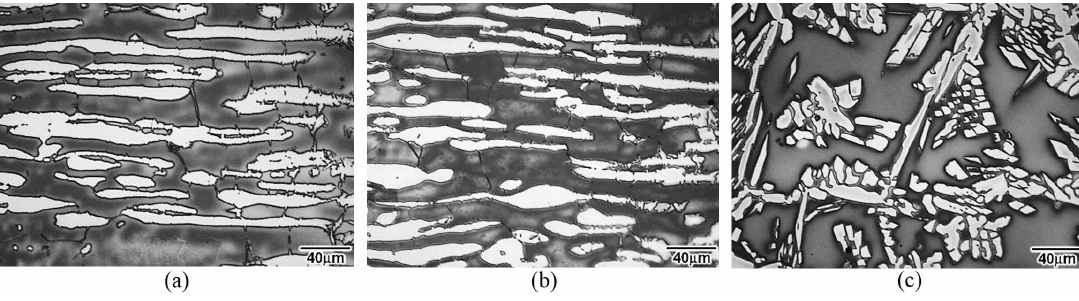
Figure 8. Microstructure of the heat-affected zone and the heat-affected zone with low temperature (HAZLT). (a) 0.5 kJ.mm -1 with a ferrite content of 57% (matrix) and plate-like austenite precipitates. (b) 1.0 kJ.mm -1 with a ferrite content of 60% (matrix) and plate-like austenite precipitates. (c) 3.5 kJ.mm -1 with a ferrite content of 55% (matrix) and plate-like austenite precipitates. The shades of grey in the ferrite matrix suggest solute segregation caused by the partial dissolution of the austenite during the welding process. OM, electrolytic etching in KOH